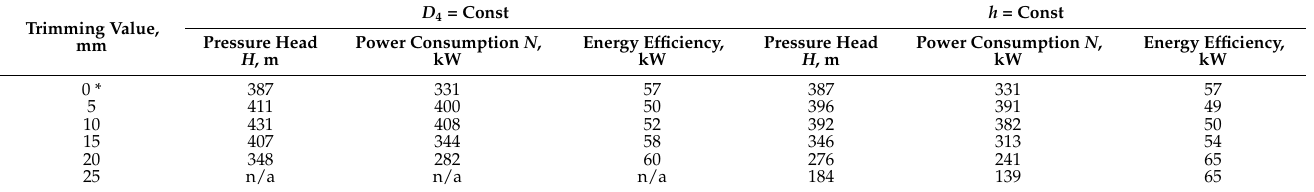
Table 1. Pressure and energy characteristics of counter-rotating stages for different trimming